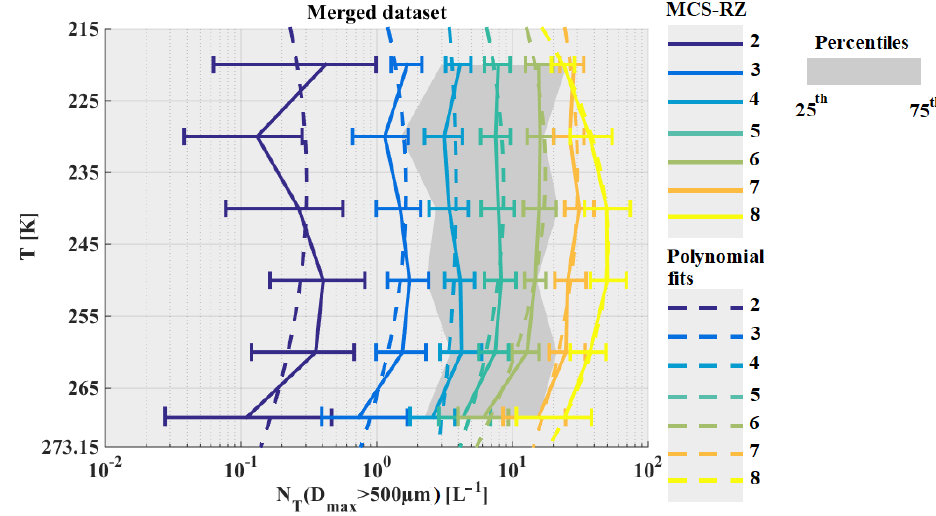
Figure 11. The same as Fig. 5 but for concentrations of hydrometeors integrated beyond D max = 500µm in L − 1 .